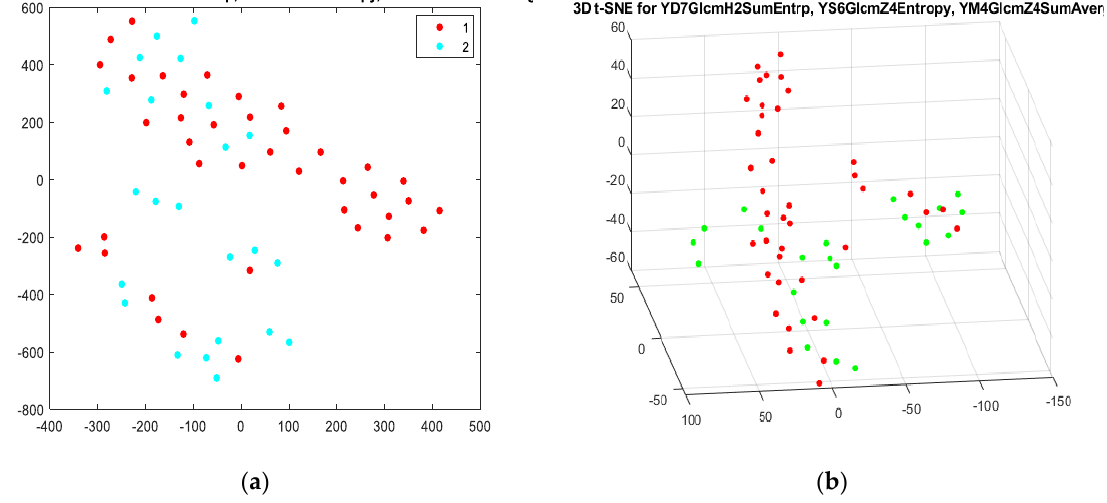
Figure 3. Two-dimensional t-SNE ( a ) and 3D t-SNE ( b ) for model I for perplexity = 20. In ( a ), class 1 (red dots) represents cysts, and class 2 (blue dots) represents granulomas. In ( b ) red dots represent cysts, and green dots represent granulomas. The aggregation of red dots suggested that the chosen texture features could be used as a predictor to differentiate these two lesions.